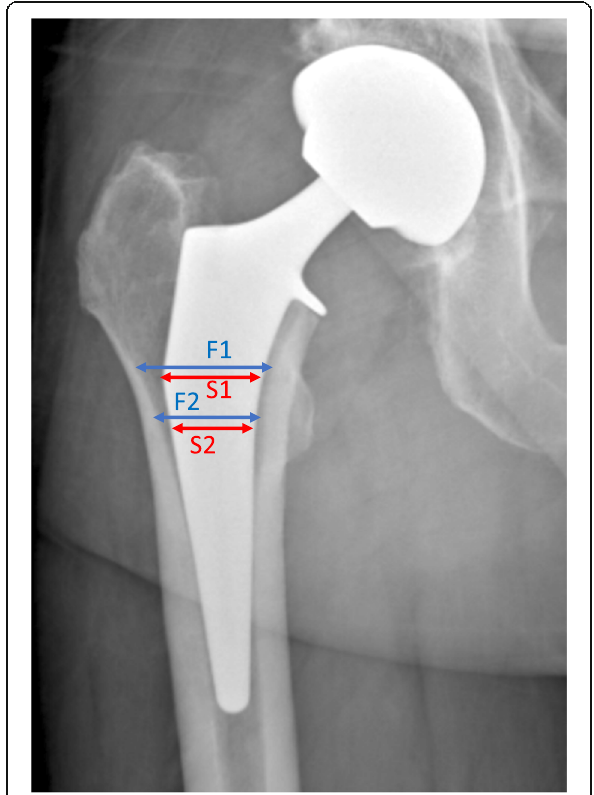
Fig. 2 Postoperative radiograph detailing the measurements of canal fill ratio. The blue lines represent the measurement of the width of the inner femoral cortex (F1), and the red lines those of the stem width (S1). The CFR is the ratio between the width of the stem and that of the inner femoral cortex (S1/F1). It is measured at both the upper edge of the lesser trochanter (F1/S1), and at its tip (F2/S2)